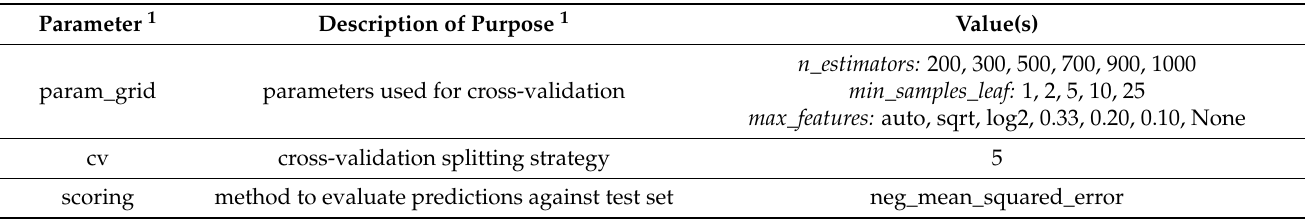
Table 6. User-defined parameters for cross-validation using GridSearchCV from the scikit-learn library. The param_grid parameters were taken from the RandomForestRegressor output. The remaining parameters were